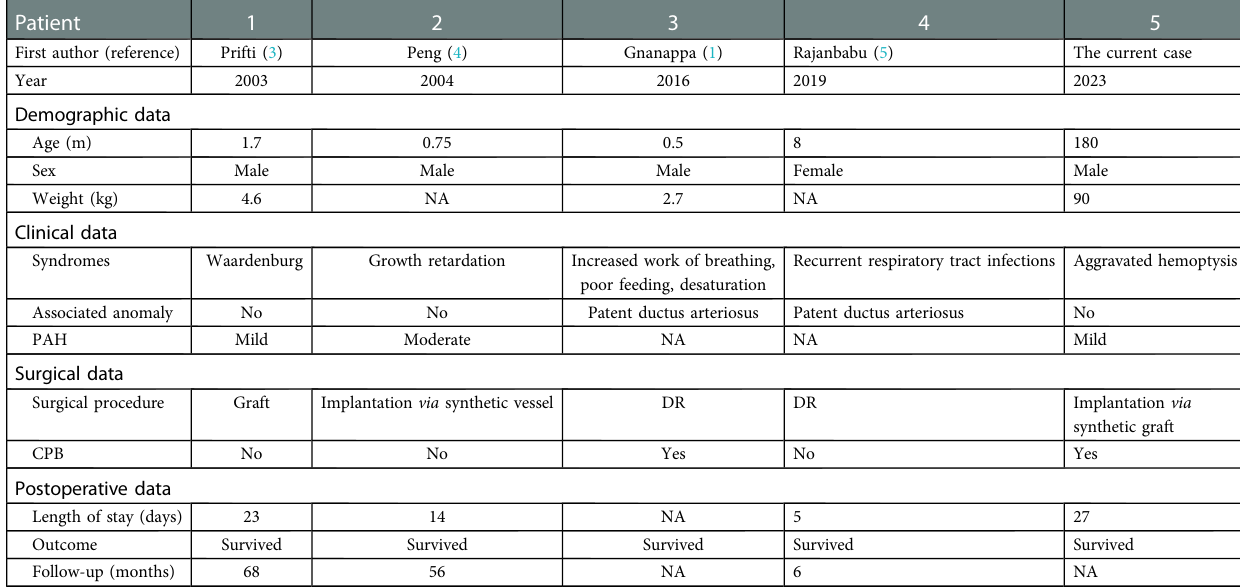
TABLE 1 The demographic and clinical characteristics in fi ve patients with AOLPA from the descending aorta.